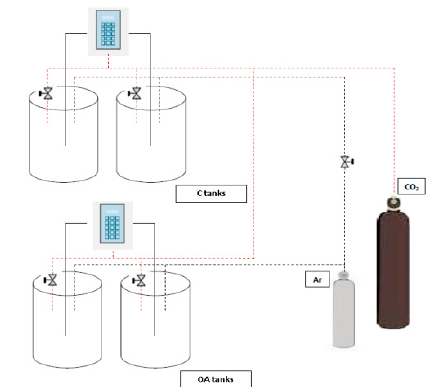
Figure 2. Design of the experimental set-up. Two tanks for each pH treatment (ocean acidification conditions/treatment (OA) and control factor conditions/treatment (C)), the IKS system monitoring the CO 2 gas supply and Ar supply.